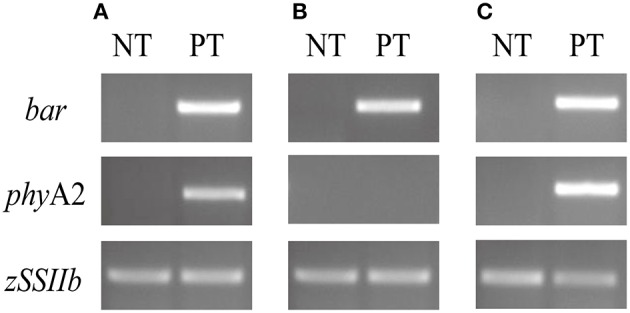
PCR and RT-PCR analysis of the bar and phyA2 transgenes. (A) PCR results for exogenous genes in maize leaves; (B) RT-PCR results for exogenous genes in maize leaves; (C) RT-PCR results for exogenous genes in maize seeds. PT, phytase-transgenic maize 10TPY006; NT, the control variety LIYU16.